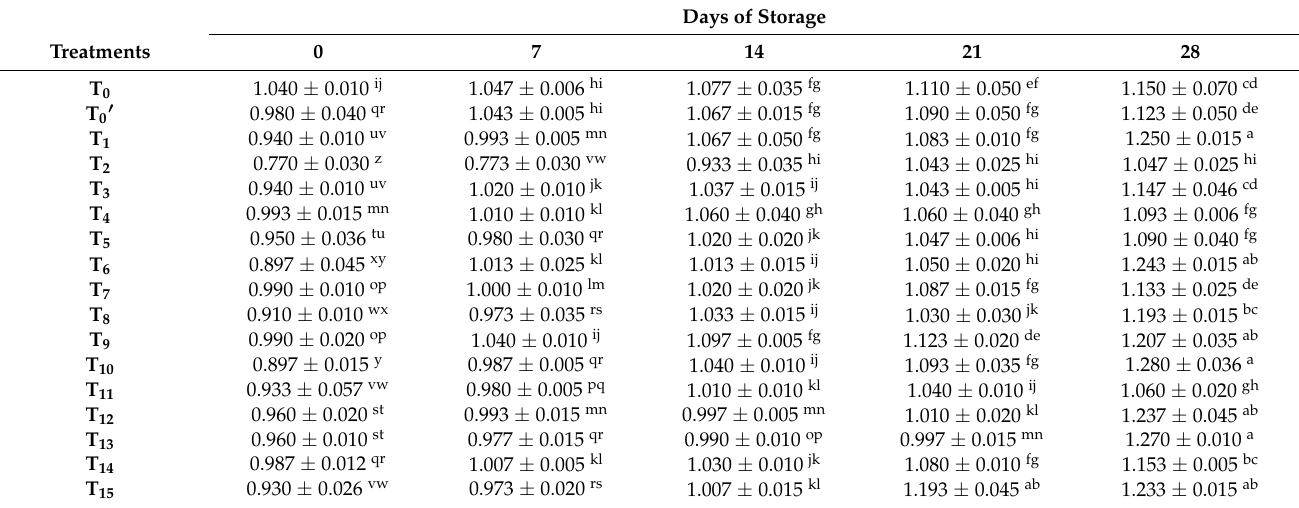
Table 5. Effect of guar gum and storage time on the acidity (%) of probiotic yoghurt. Days of